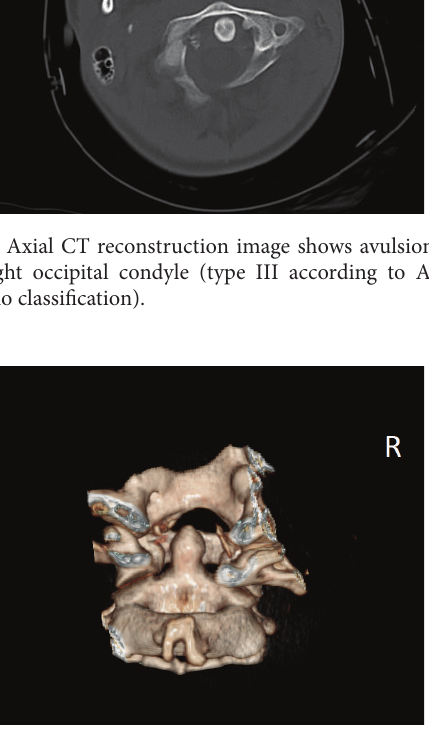
Figure 2: Three-dimensional CT reconstruction image shows avul- sion fracture of the right occipital condyle (back view).